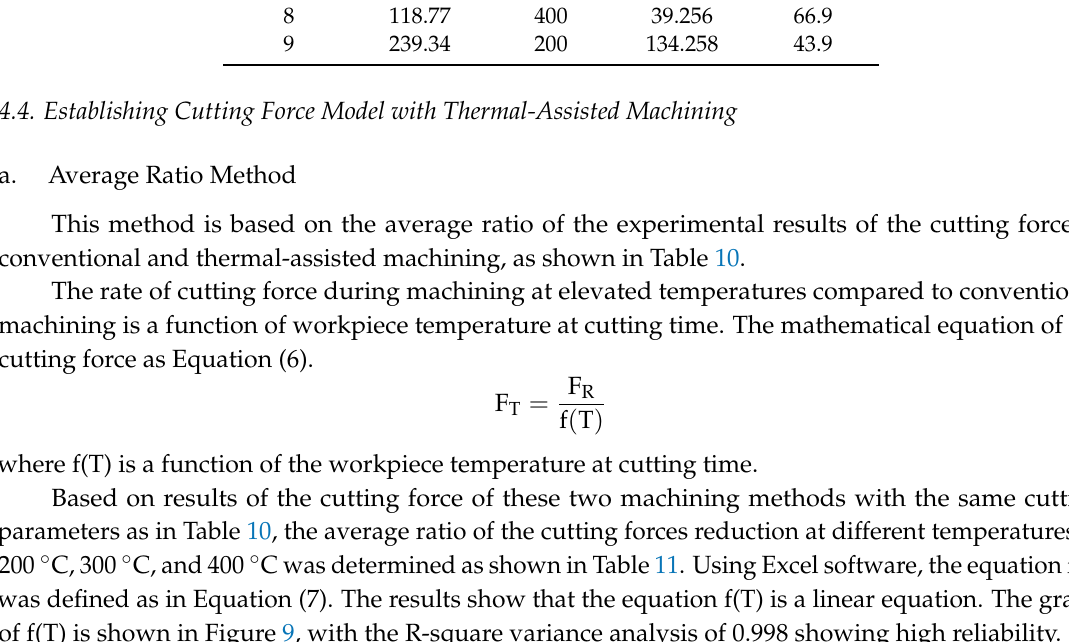
Table 11. Average ratio of cutting force reduction.